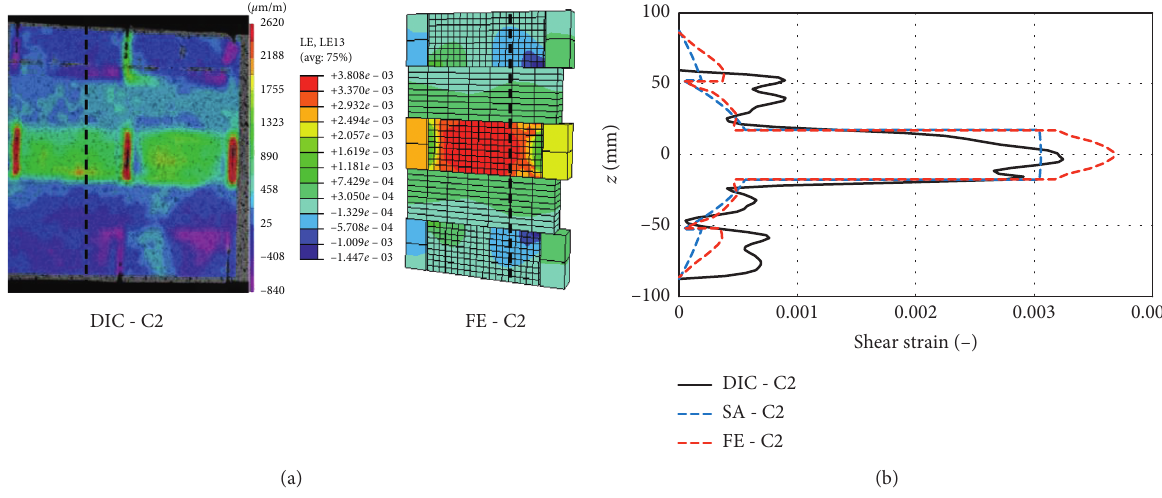
Figure 14: Colour contour plots and shear strain distribution from bending tests for